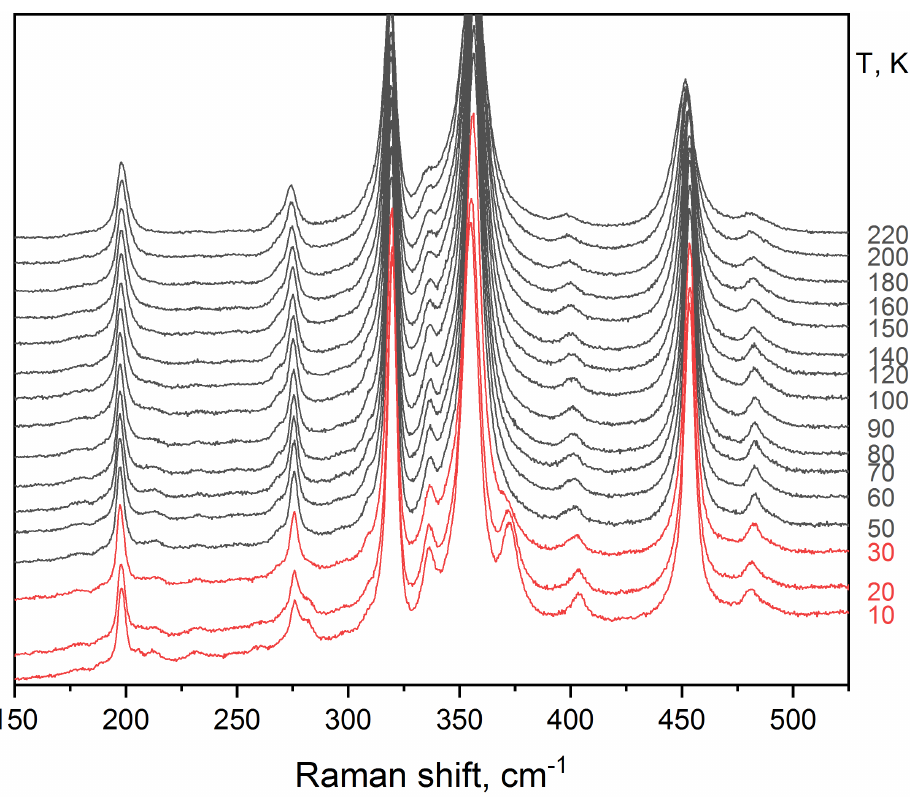
Figure 2. Raman spectra transformation with temperature of TbFe 2.46 Ga 0.54 (BO 3 ) 4 in the mid- wavenumber region. Color code: black— R 32 phase, red— P 3 1 21 phase.